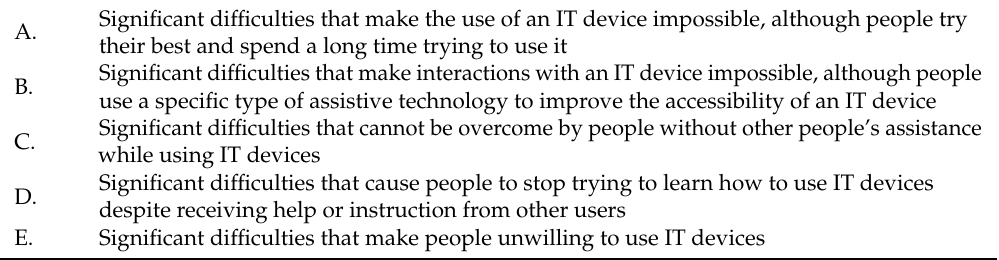
Table 1. Five attributes of the ITID concept [3].